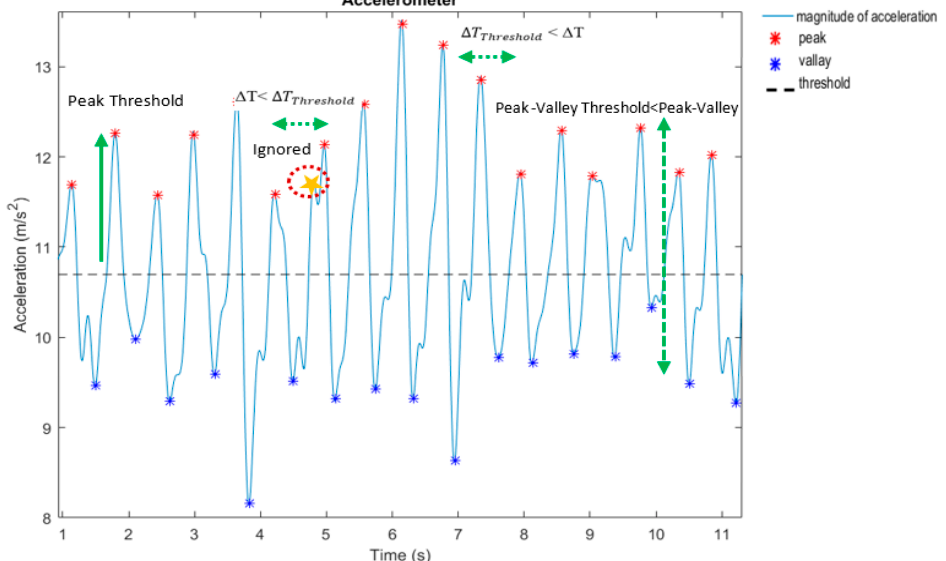
Figure 9. Thresholds of the peak detection method.